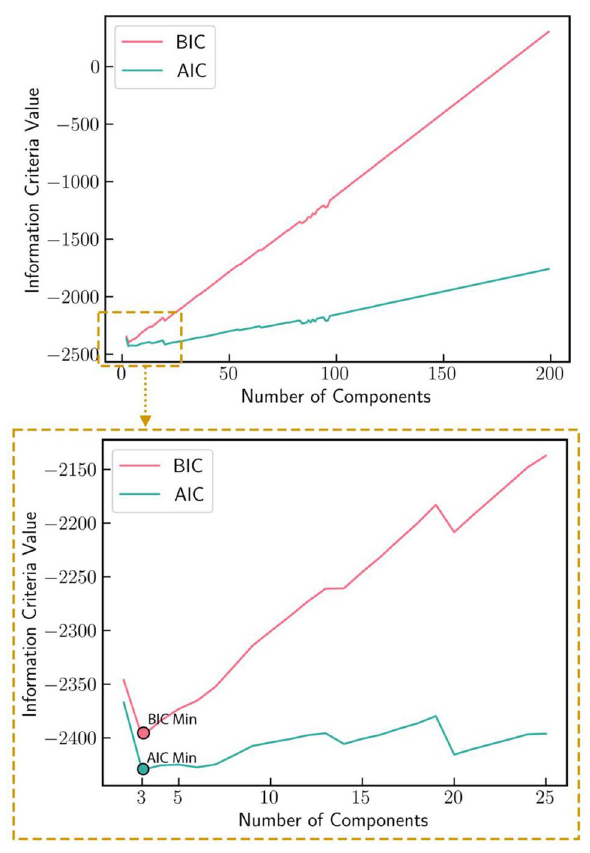
Fig. 5 Calculated BIC and AIC for different numbers of components from 2 and 200 with tied covariance type for sandstone